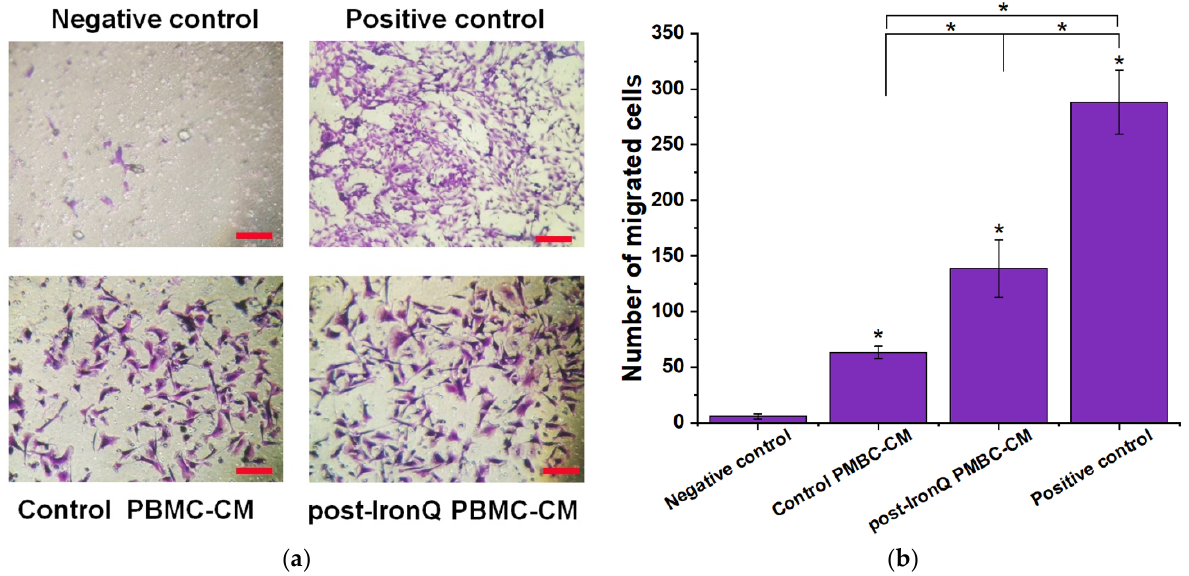
Figure 5. The effect of IronQ-preconditioning PBMC secreted factors on the migration of HUVECs. The HUVECs were cultured in the upper chamber of the Transwell chambers, with serum-free medium (0.1% FBS), and the lower chambers were filled with 0.1% FBS medium (negative control), 0.1% FBS + control PBMC-CM, 0.1% FBS + post-IronQ PBMC-CM, or 10% FBS medium (positive control). ( a ) After 24 h, the number of cells on the lower surface of the upper chamber was counted under an inverted microscope at ×100 magnification. ( b ) Quantification of HUVEC cell migration (violet stained cells) using a Transwell chamber. The quantitative evaluation of the number of cells migrated to the lower surface of the Transwell chamber under different conditions after 24 h of the culture period. Data are expressed as means ± SD ( n = 8). * p < 0.05.